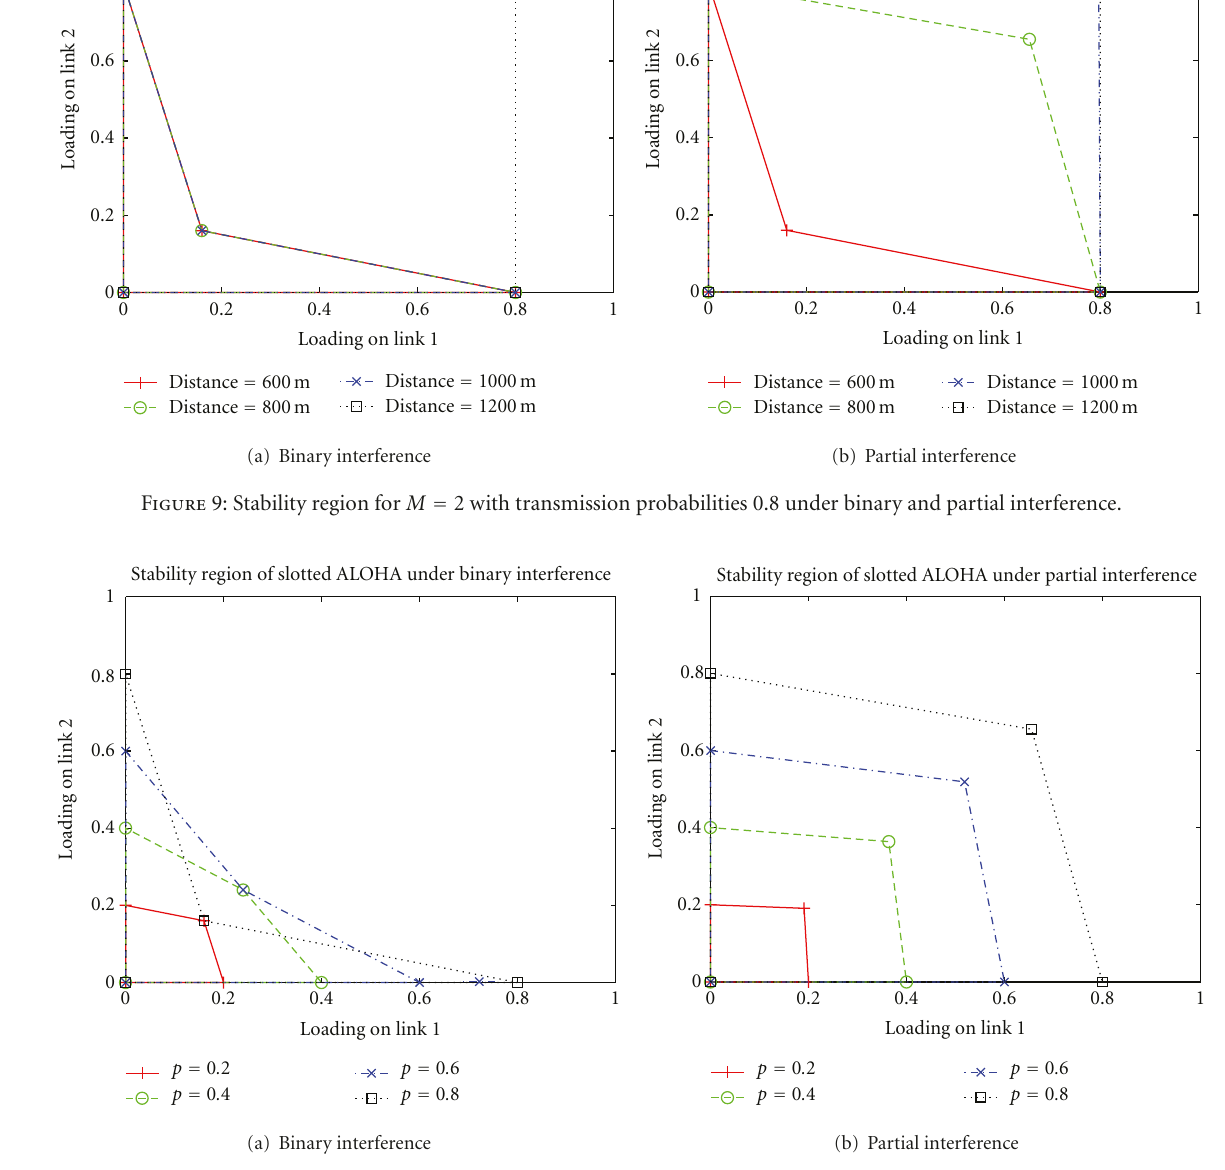
Figure 10: Stability region for M = 2 with link separation 800 meters under binary and partial